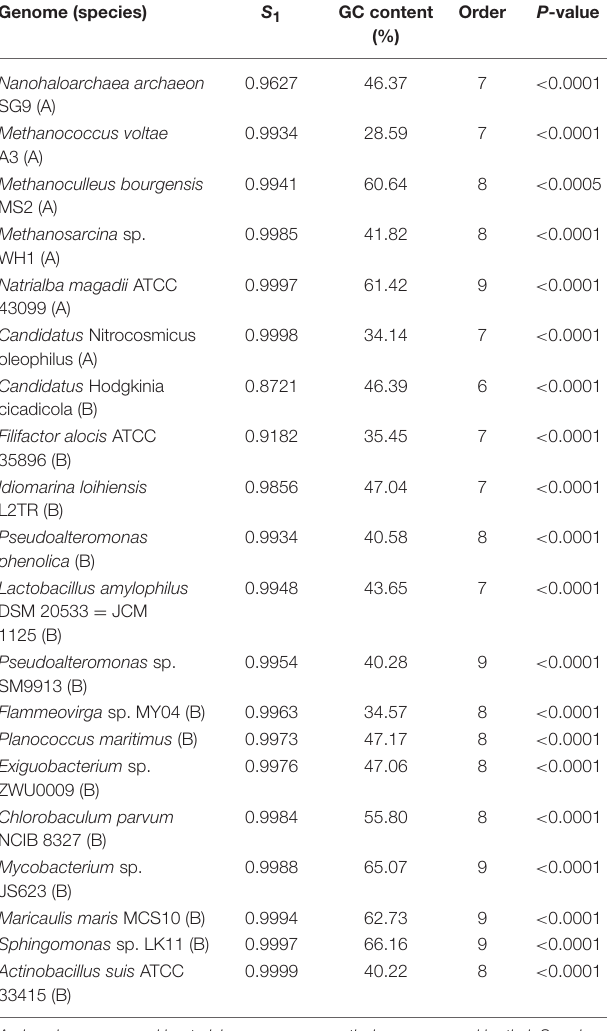
TABLE 4 | Extent of strand symmetry determined by word symmetry distance analysis ( WSD 2) in individual genomes with different mononucleotide symmetry levels ( S 1 ) and GC